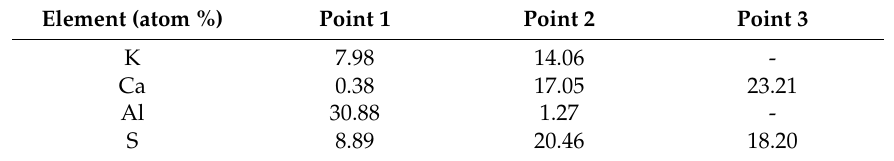
Figure 7. Scanning electron microscopy (SEM) observation and energy dispersive spectrometry (EDS) mappings of the sample calcinated at 800 ◦ C for 30 min (CaO: alunite = 0.4). Table 2. Energy dispersive spectrometry (EDS) spot analysis of the calcinated sample in Figure 7.